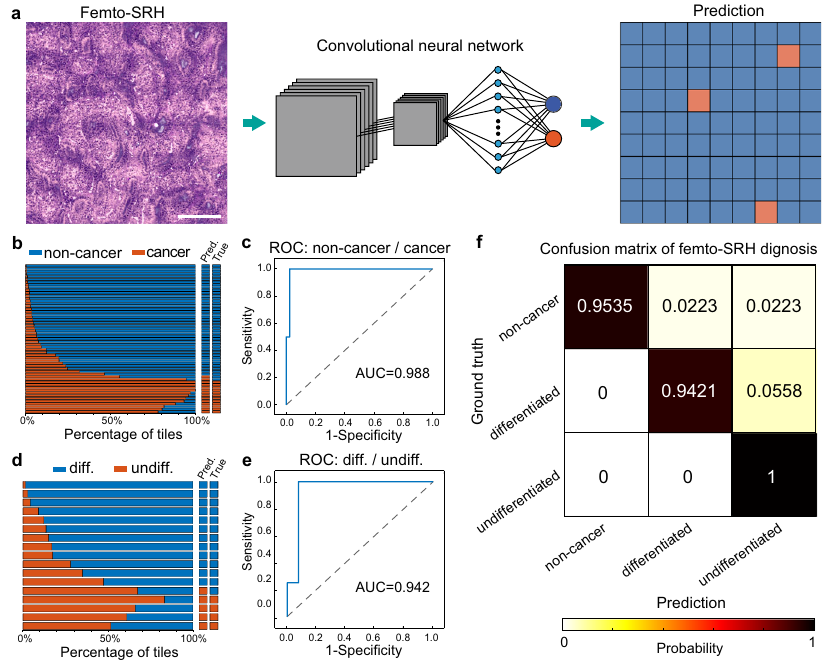
Fig. 5 Automated diagnosis with deep convolutional neural networks (CNNs) on femto-SRH images. a Schematics of CNN predictions; b , c Training, validation and test results of the neural network for the classi fi cation of non-cancer/cancer tissues; d , e Training, validation and test results of the neural network for the classi fi cation of differentiated/undifferentiated cancers. f Confusion matrix of the three diagnostic subtypes. Scale bar: 200 µ m. Source data are provided in the Source data fi le.